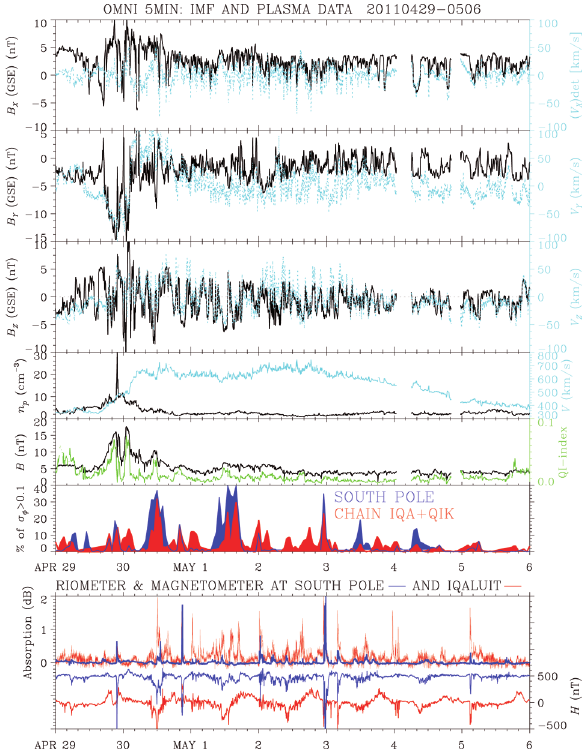
Figure 2. Solar-wind magnetic field and plasma parameters from the OMNIWeb dataset combining available solar-wind-monitor data projected to the nose of the Earth bow shock. The quasi in- variant (QI) index is superposed as the green line. Hourly occur- rences of phase scintillation, riometer absorption and magnetic H-component observed at Iqaluit-Qikiqtarjuaq (IQA/QIK) and South Pole (SP) are shown in red and dark blue,